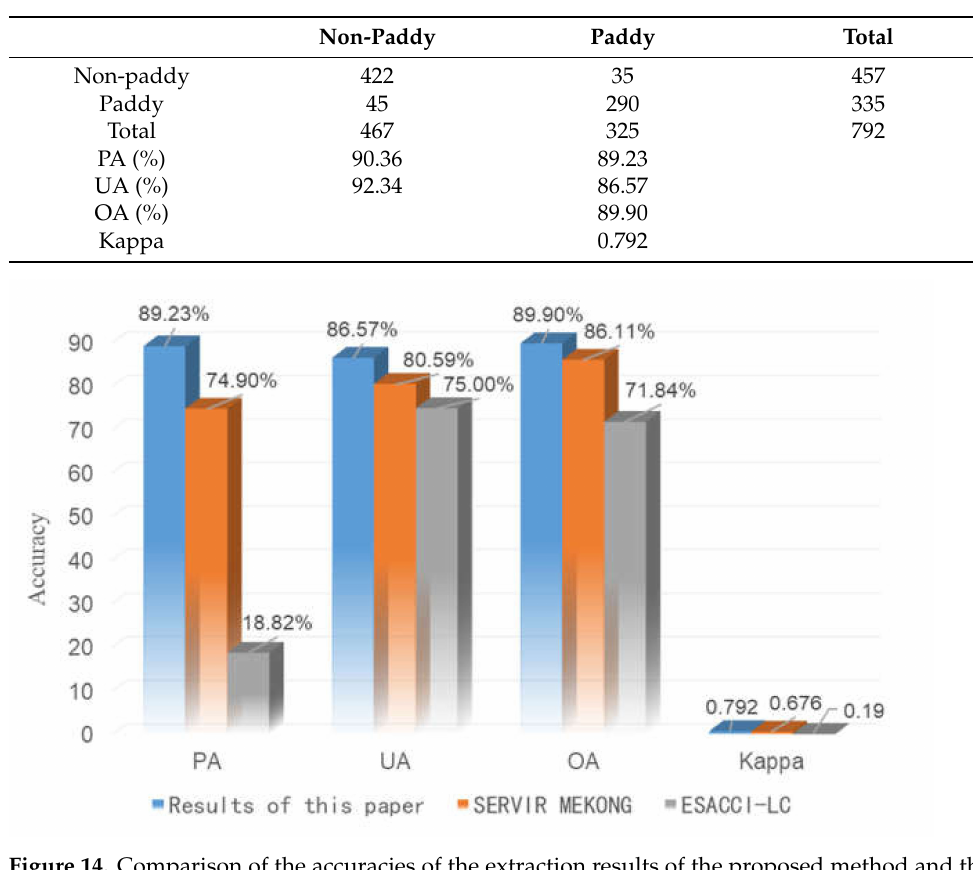
Table 4. Confusion matrix of the extraction results.